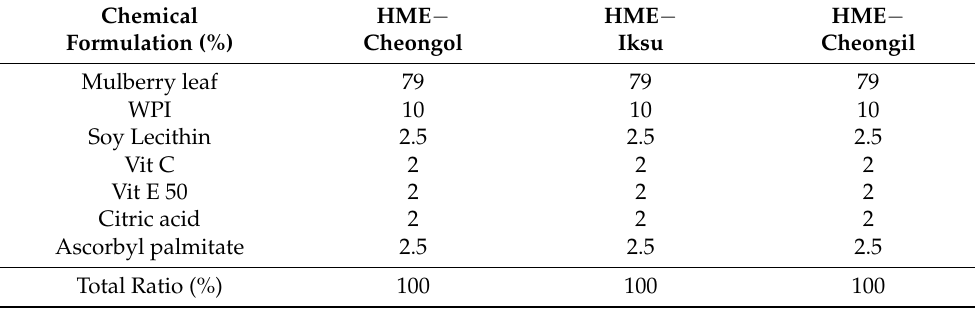
Table 1. The composition of HME − ML.